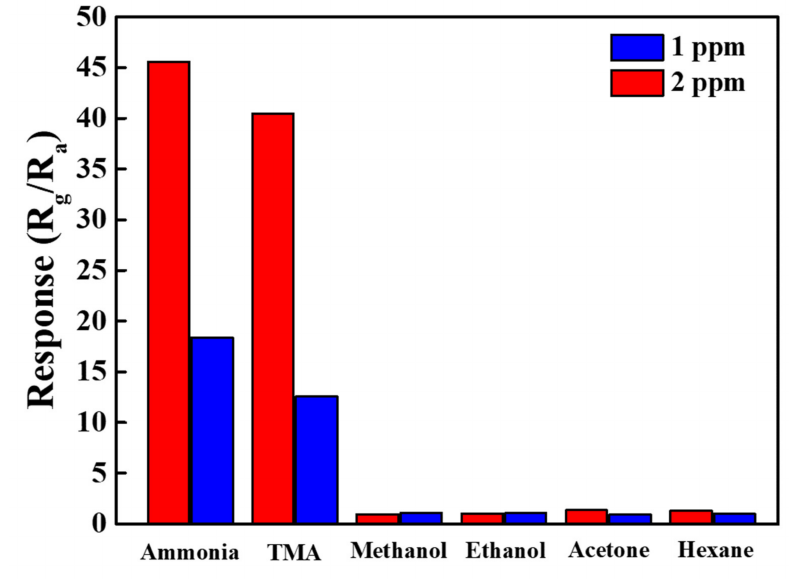
Figure 9. The selectivity of the PANI/hollow C#In 2 O 3 nanofiber sensor toward NH 3 , trimethylamine (TMA), methanol, ethanol, acetone, and hexane with a concentration of 1 and 2